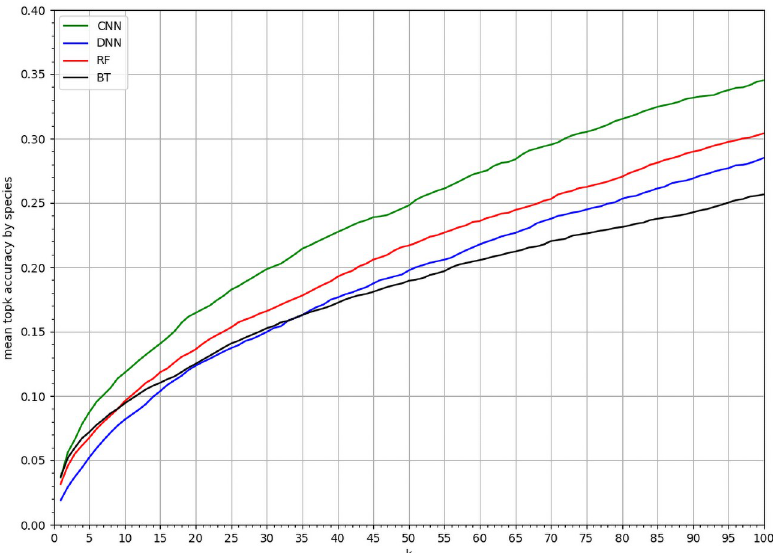
Fig 4. Performances comparison. MSA